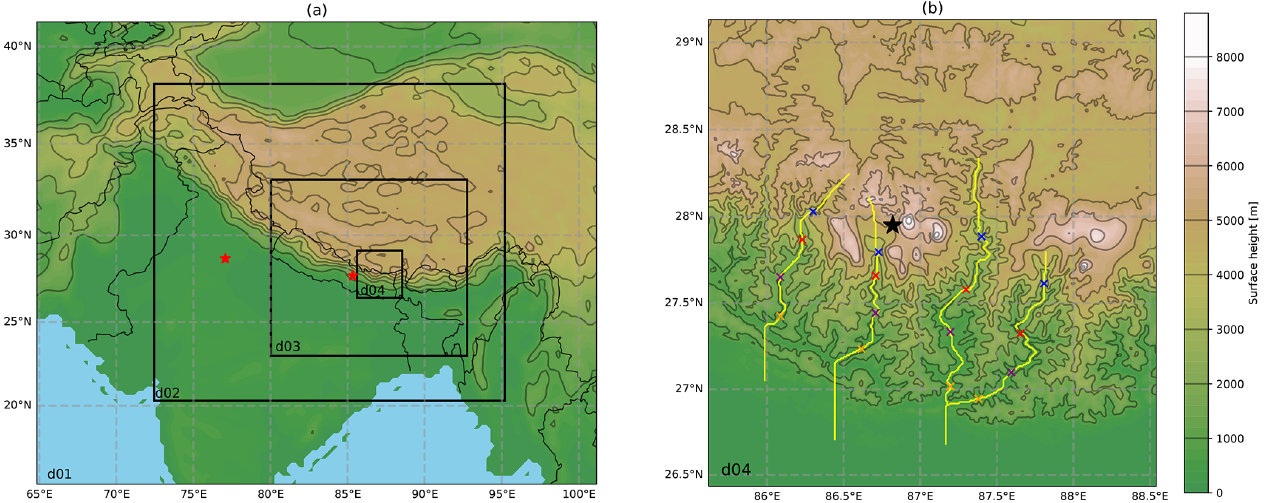
Figure 2. (a) Topography of the d01 domain and the inner domains, d02, d03 and d04, in the WRF simulation. Thin solid lines denote the country borders. Red stars denote the location of Kathmandu (the furthest east star) and New Delhi. (b) Topography of the d04 domain. Yellow lines present the valley centre lines used in the analysis. Valley names are listed from west to east: Gaurishankar, Khumbu, Makalu and Kanchanjunga. The black star indicates the location of the Nepal Climate Observatory – Pyramid (NCO-P) station. Coloured crosses denote locations along the valley centre lines that are referred to in the text and other